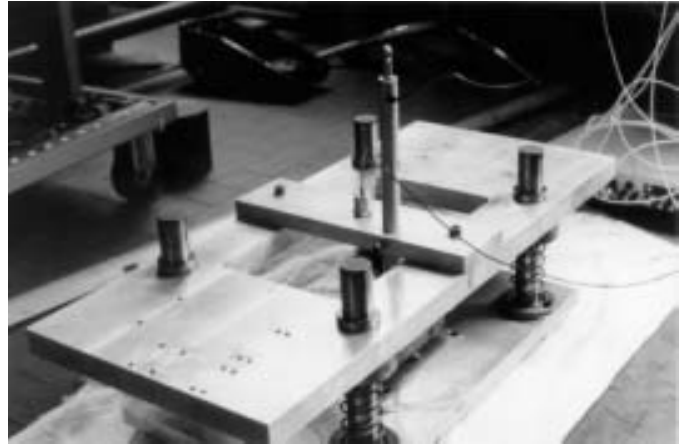
Fig. 1. Experimental set-up.